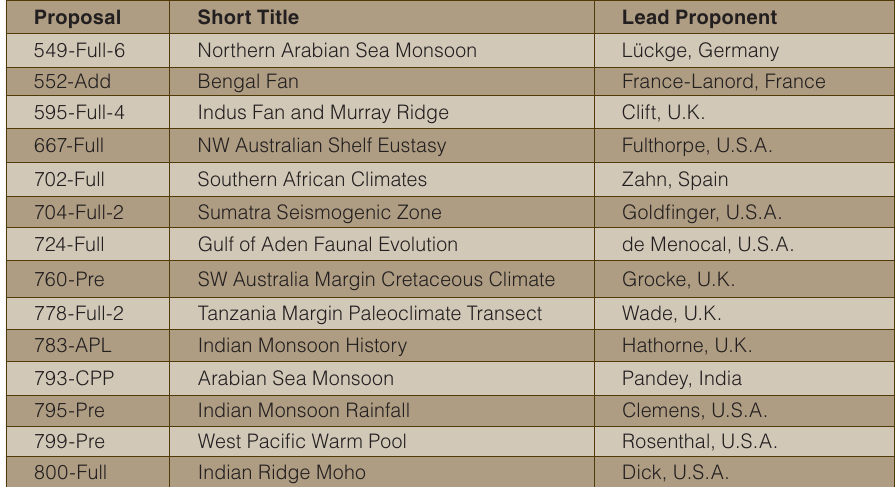
Table 1. A list of the current active proposals in the Indian Ocean.